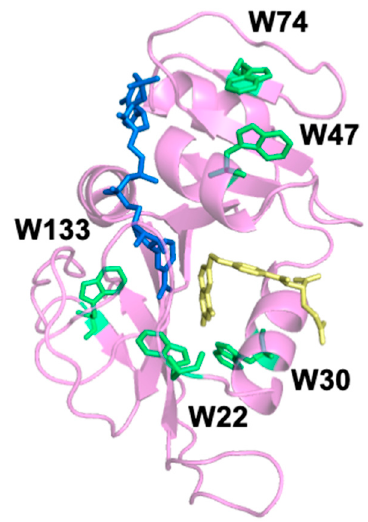
Figure 1. Crystal structure (Protein Data Bank: 1RX2) of wild-type E. coli dihydrofolate reductase (DHFR) (magenta) with oxidized nicotinamide adenine dinucleotide phosphate (NADP + ) cofactor (blue) and folate (yellow). The five native tryptophan (Trp) residues are labeled and shown in green.